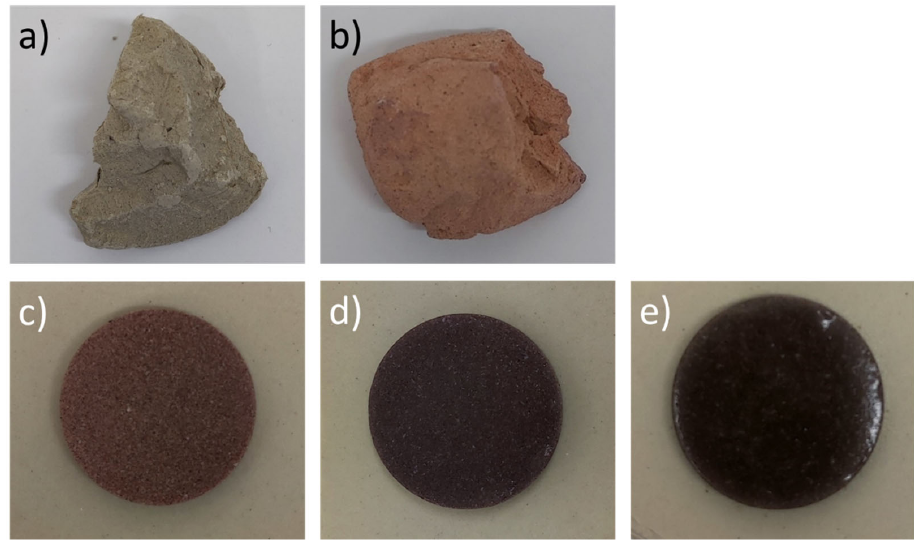
Figure 2. GS after drying ( a ) and after fi ring at 1000 °C ( b ), 1100 °C ( c ), 1150 °C ( d ), and 1200 °C ( e ).